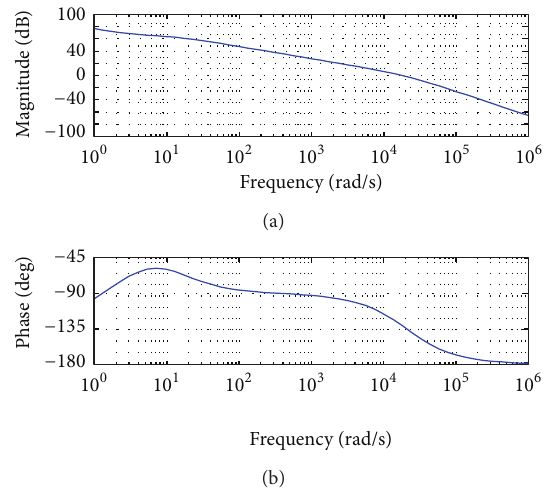
Figure7:Thefrequencycharacteristicofboostconverterbeforeand after